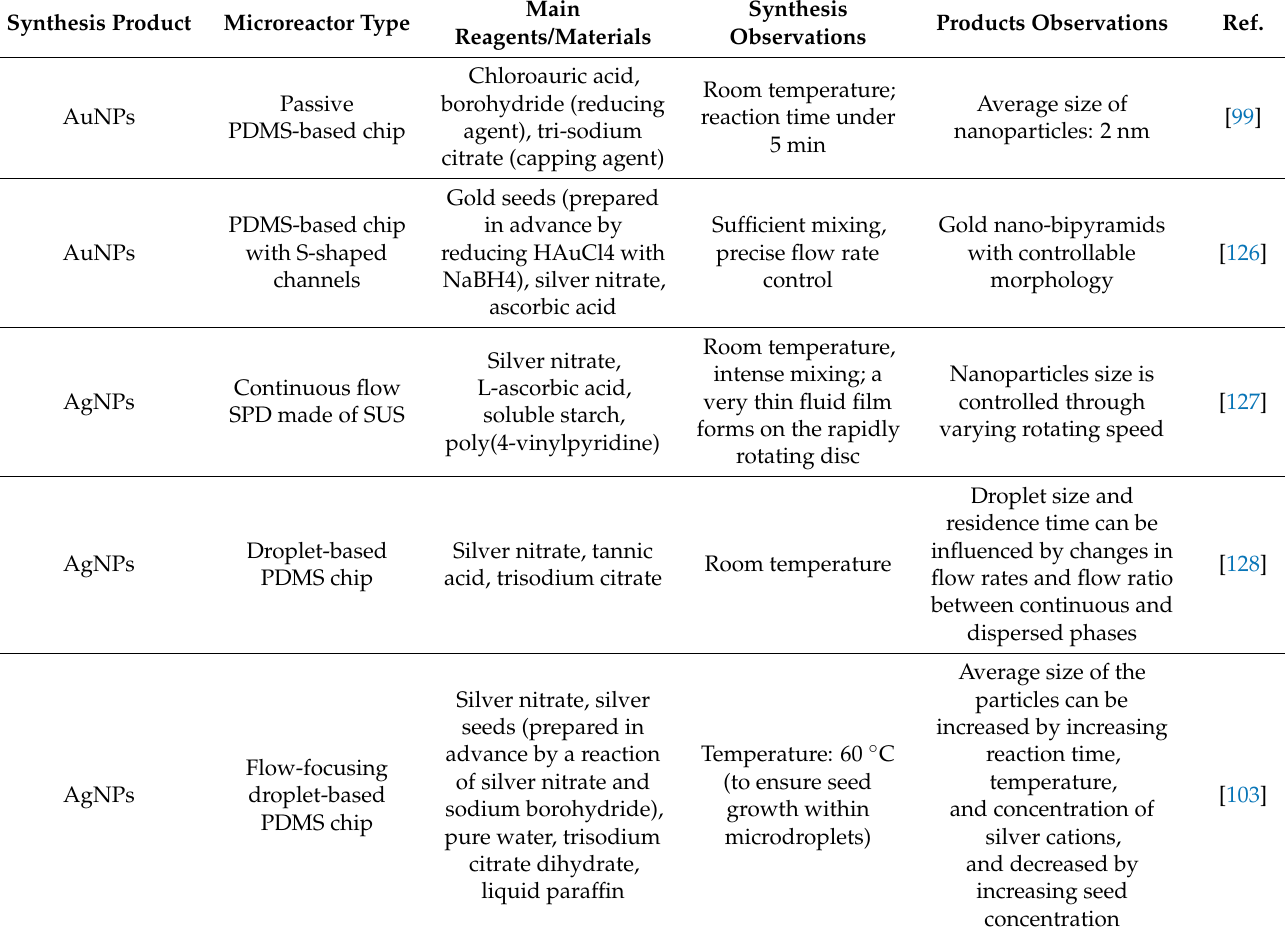
Table 3. Summary of inorganic nanomaterials synthesized via microfluidic